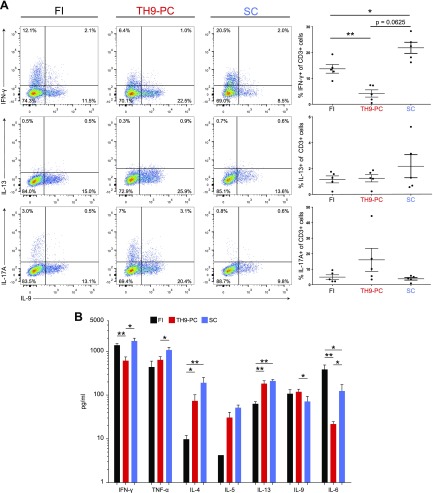
IL-9+ skin-derived T cells do not coexpress Th1, Th2, or Th17 signature cytokines. A) Flow cytometric dot plots with indicated cytokine analyses and gating on CD3 (left panel) after cells were stimulated with αCD3 and αCD28 beads for 3 d and restimulated with CSC for 4 h. Quadrants were set according to isotype-matched control staining. Percentage of cytokine-expressing T cells among total CD3+ T cells was determined from 5 different donors (right panel). B) Cytokine concentrations in supernatants from αCD3 and αCD28 bead–stimulated cultures 3 d were determined by cytokine bead array (n = 7/group). In the IL-5 group with FI cells, cytokine concentrations of only 2 donors were above the detection limit of the bead array. Data represent means ± sem. FI vs. Th9-PC and SC were compared using a Mann-Whitney U test and Th9-PC vs. SC using Wilcoxon’s rank-sum test. *P ≤ 0.05, **P ≤ 0.01.